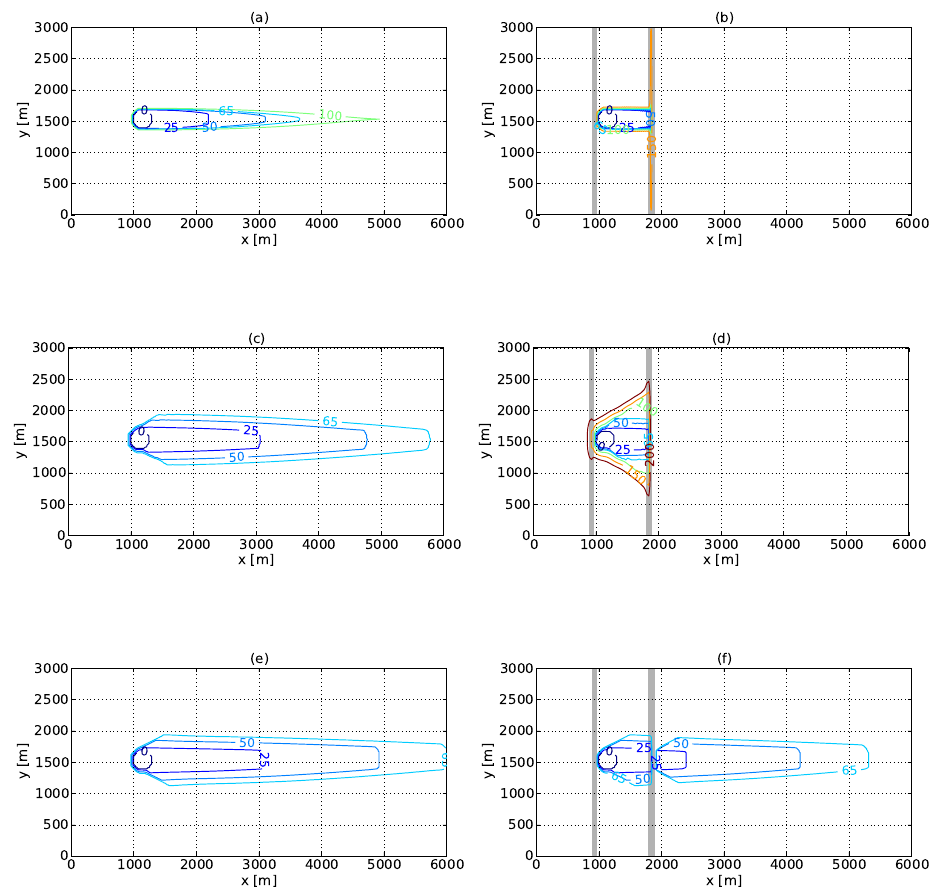
Figure 4. The same as in Fig. 1, but when the mean wind velocity and the fire intensity are U t =17.88ms − 1 and I =30000kWm − 1 (case D Fig. 4. The same as in Fig. 1 but when the mean wind velocity and the fire intensity are U t = 17 . 88ms − 1 and I = 30000 kW m − 1 (case D ).